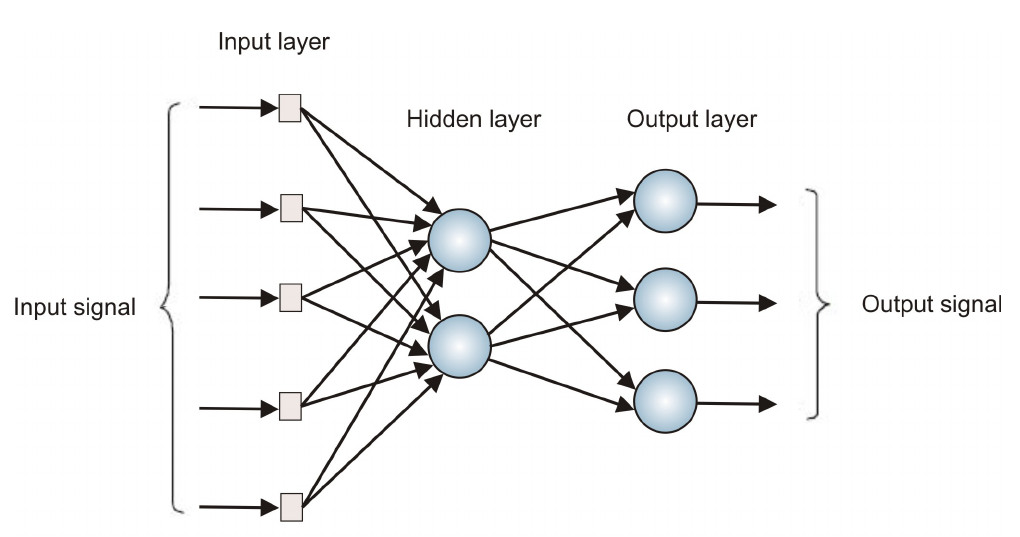
Figure 7. Structure of a multilayer perceptron